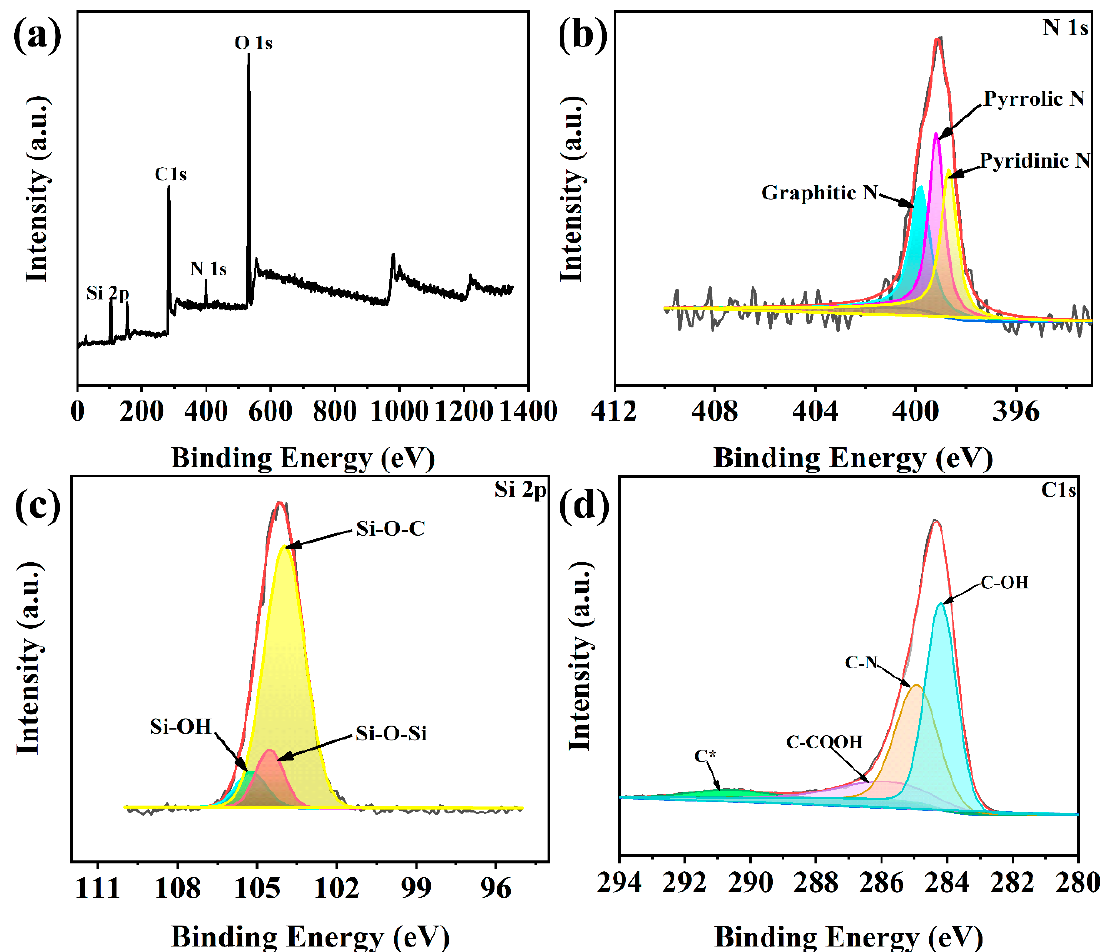
Figure 2. XPS spectra of DDM − GO@SiO 2 composites ( a ) Survey XPS spectra, ( b ) N1s, ( c )Si 2p, ( d ) C1s.